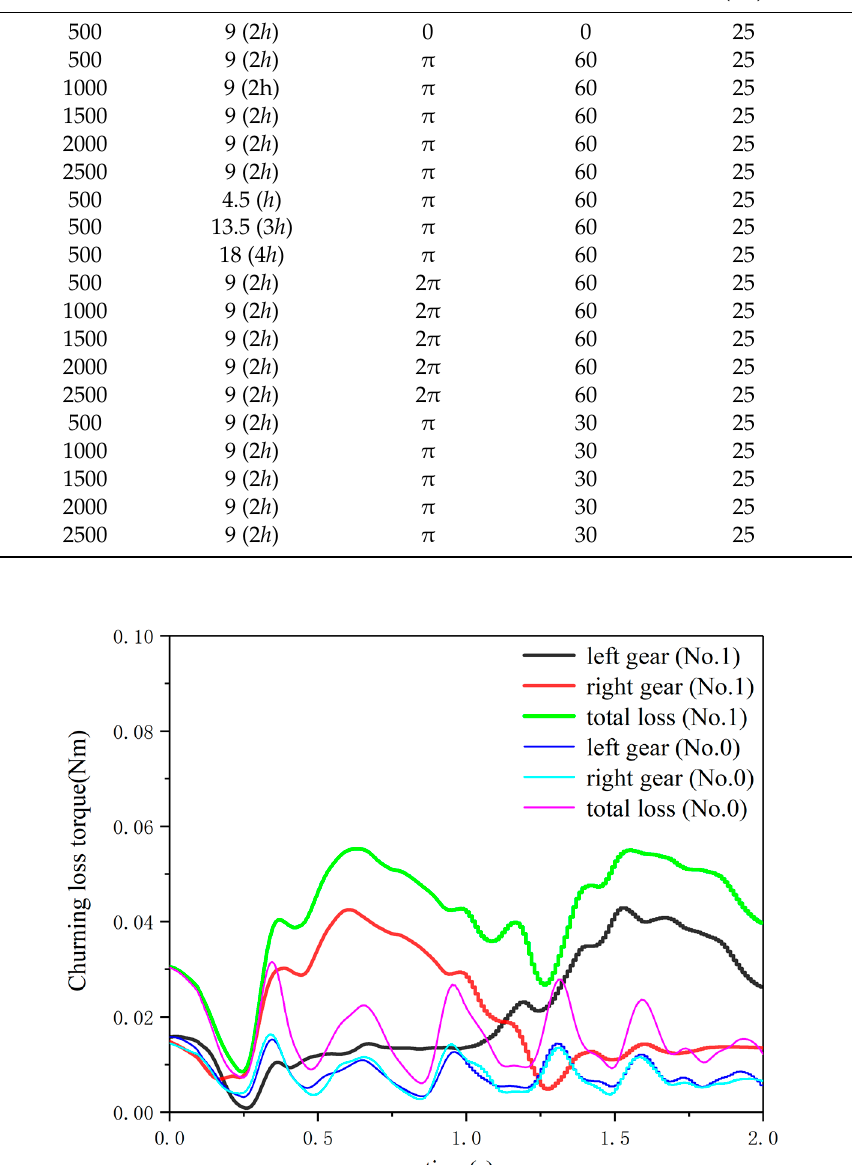
Figure 7. Average churning loss torque with and without motion of the gearbox.